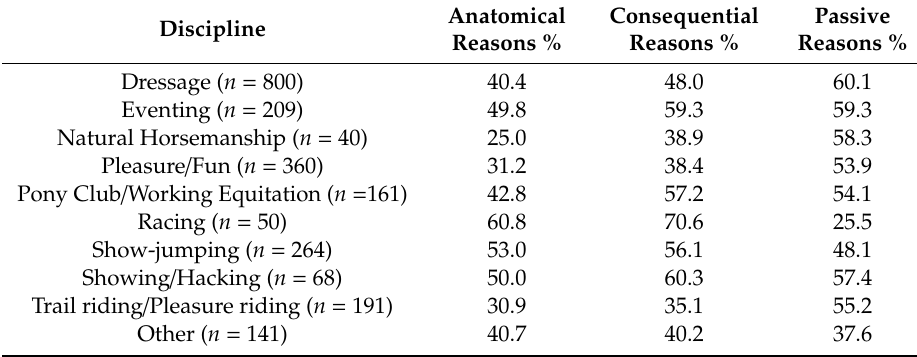
Table 6. Frequency across disciplines of Anatomical, Consequential or Passive reasons for noseband use. Respondents (who used nosebands, n = 2332) were asked to select up to five responses from the list of reasons. Percentages reflect the percentage of respondents within a discipline who selected at least one reason from Anatomical, Consequential or Passive.